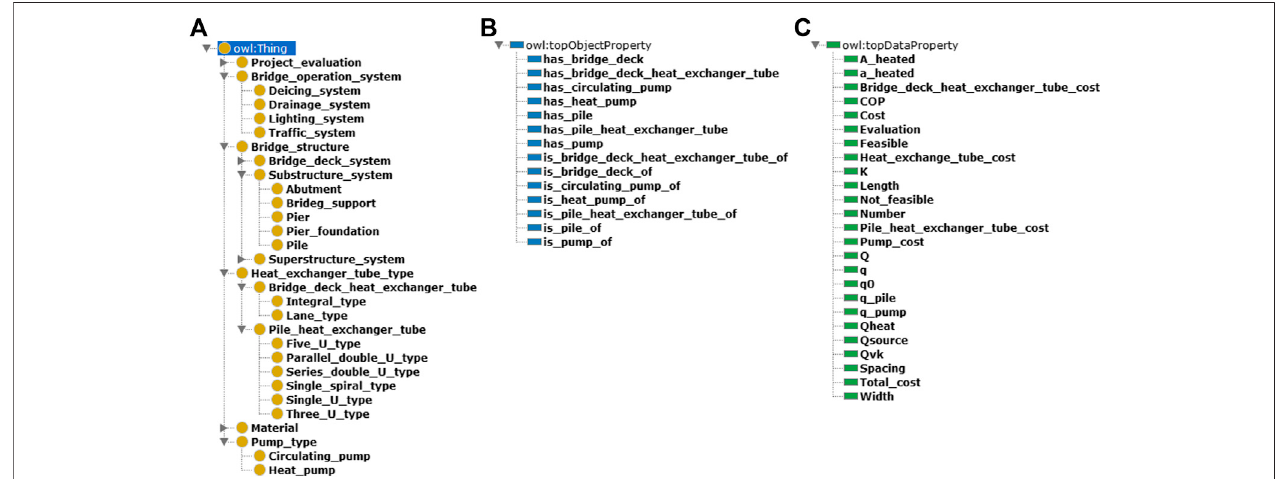
FIGURE 6 | The development ontology in the Protégé-OWL 5.2.